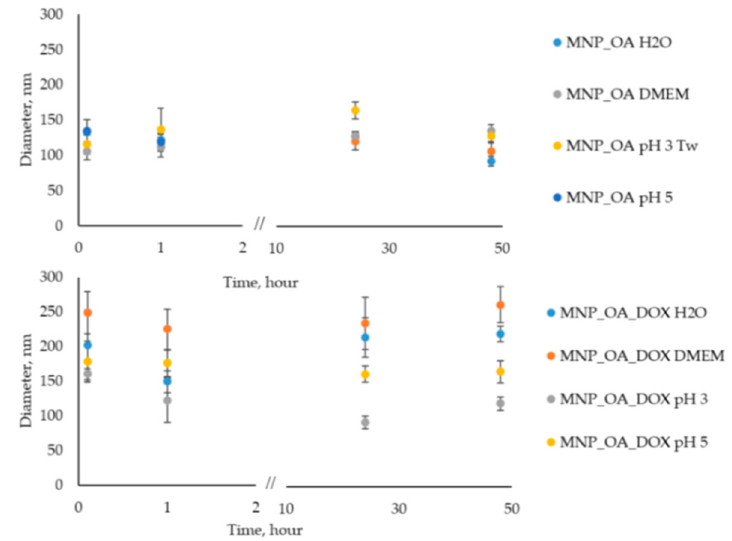
Figure 6. Hydrodynamic size variation of 0.13 mg/mL MNP_OA and MNP_OA_DOX evaluated by DLS for 48 h in 100 mM acetic buffer (pH 3 and 5), deionized water (Milli-Q), and cell medium DMEM (100%). For the MNP_OA sample at pH 3 Tw20 (0.5% w), surfactant was added to improve stability.